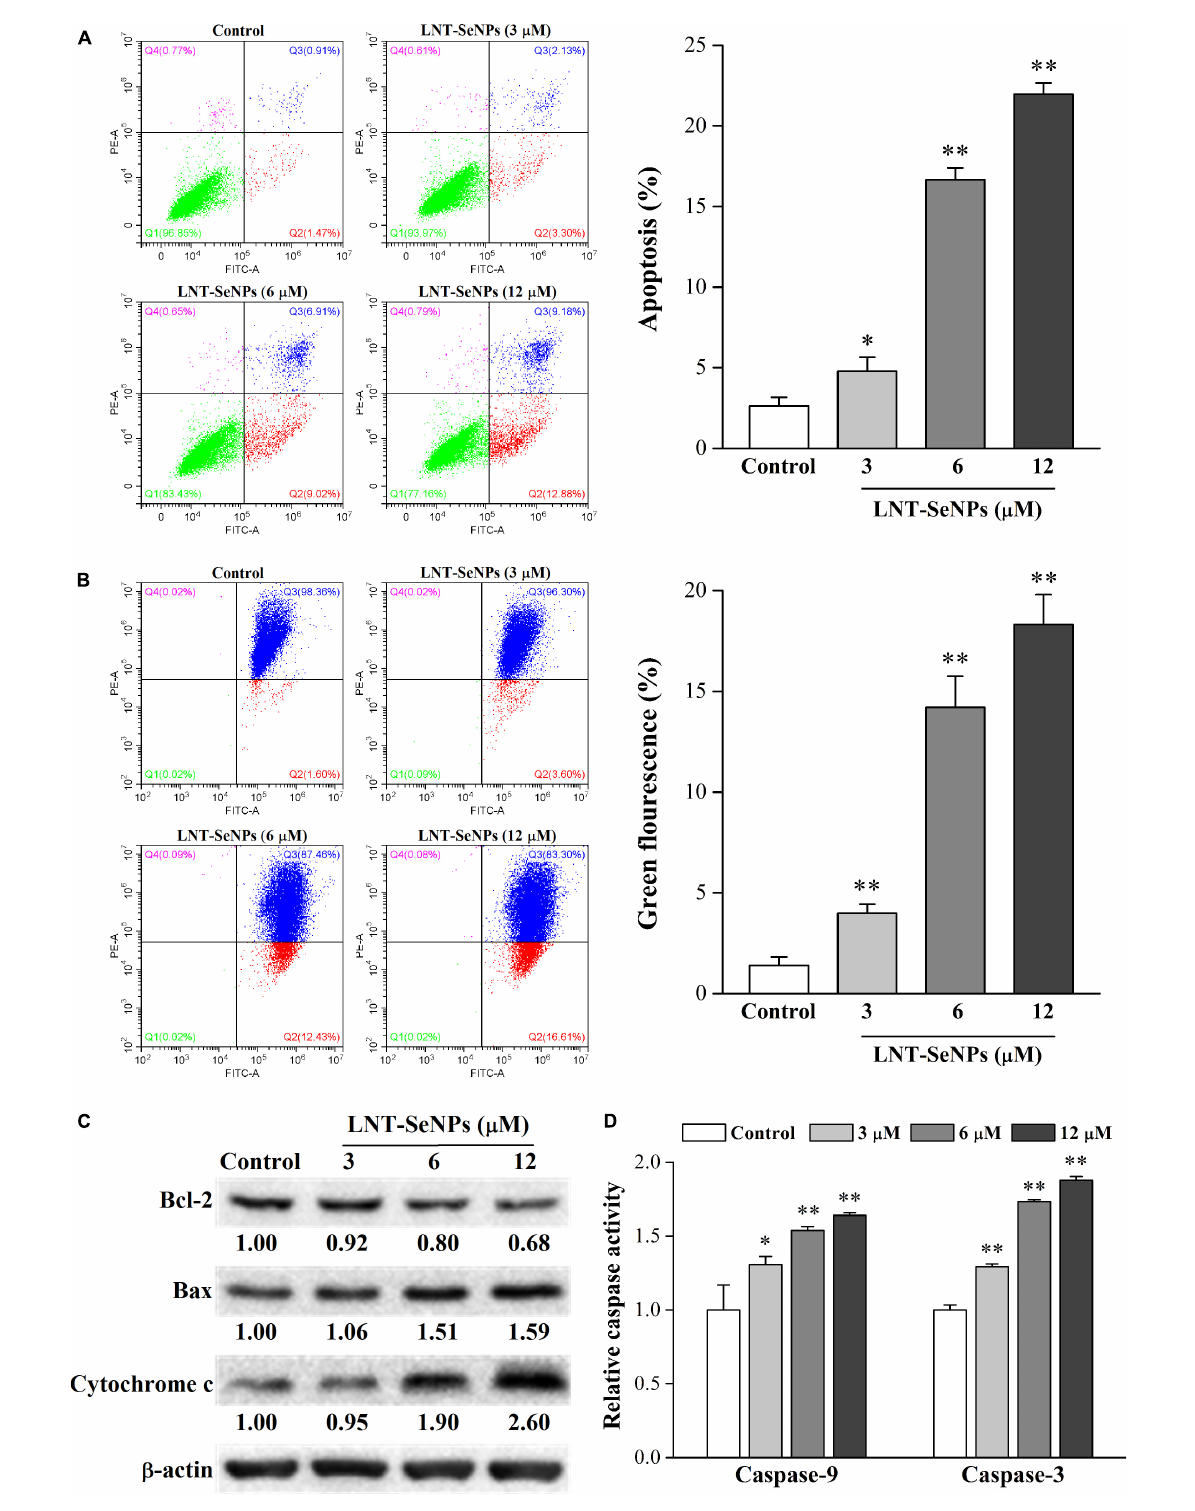
FIGURE6 Effects of LNT-SeNPs treatment (3, 6, and 12 µ M) on the mitochondria-mediated apoptotic pathway in HCT-116 cells. The apoptosis induction of HCT-116 cells was evaluated by Annexin V/PI double staining (A) ; the change of MMP was measured by JC-1 staining (B) ; the protein expression levels of Bcl-2, Bax, and cytochrome c were detected by western blot (C) ; the caspase-9 and –3 activities were determined by colorimetric assay kit (D) . Data were shown as mean values ± SD ( n = 3). ∗ p < 0.05 and ∗∗ p < 0.01 compared to the control